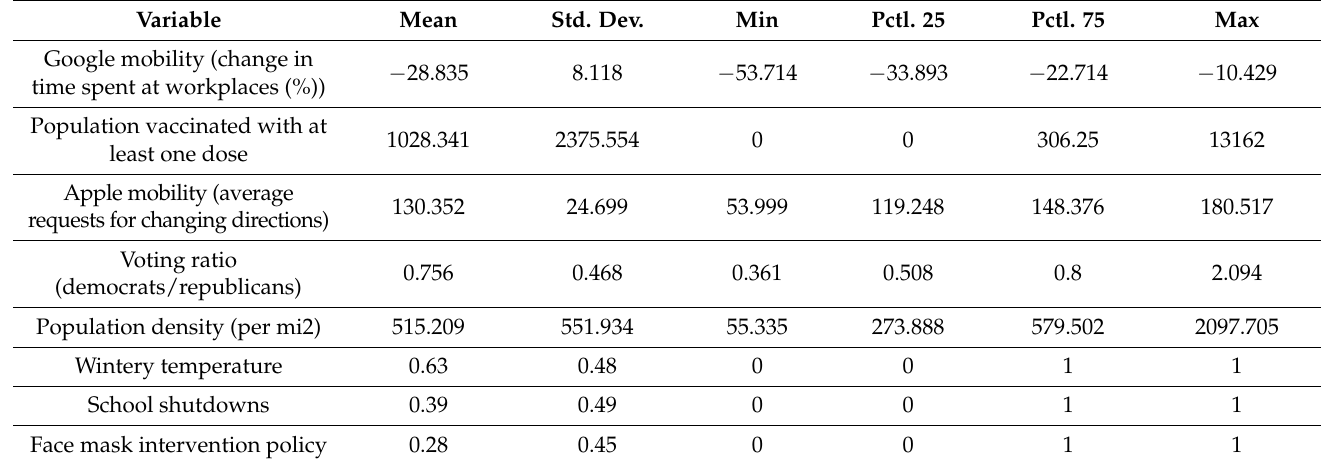
Table 1. Descriptive statistics of variables used in the final exposure